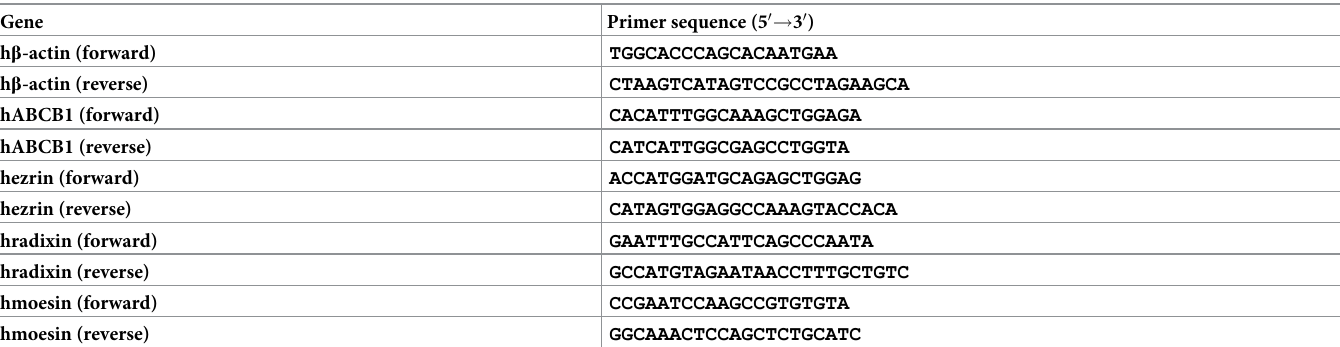
Table 1. Primer sequences used for RT-PCR analysis of gene expression.